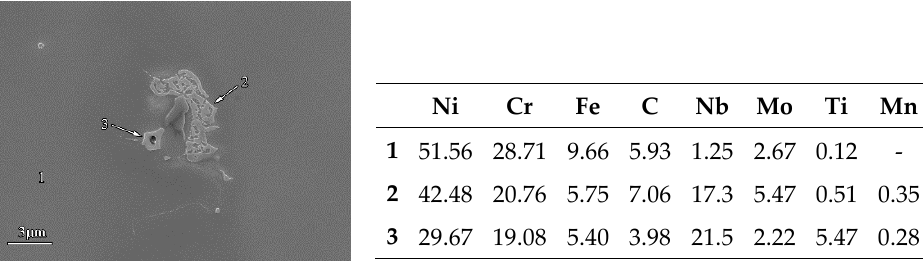
Figure 13. Compositions of precipitates in the GTAW welds of Alloy 52MSS. With an application of EMS, the dendrites of all welds became denser. The fine pre- cipitates, i.e., TiN/Cs in Alloy 52 welds, and NbCs/(Nb,Si)Cs in Alloy 52M/52MSS welds were evenly distributed in the inter-dendritic areas. The cap region was a little different in the microstructure from the middle region. There were many tiny precipitates in the middle region, but none in the cap region. This could result from welding thermal cycling that induces the fine precipitates in the middle region. In the cap region, a rapid cooling rate could inhibit the formation of tiny precipitates. Both Alloy 52 and Alloy 52M welds were characterized by a microstructure of cellu- lar dendrites (Figures 5–7). With the EMS applied, the dendrites of Alloy 52 welds grew finer, but those of Alloy 52M became coarser. A discussion on the phenomena observed with Alloy 52M welds is given below. In Alloy 52MSS welds (Figure 12), the precipitates are noted to become finer with EMS, except for the cap region. It has been indicated that EMS could refine the grains and compositional segregation of welds [18,19,23,24,26]. With grain refinement, there will be more interdendritic regions with smaller area. Therefore, this helps the large precipitates to reduce in size and distrib- ute more evenly. Besides, welding heat would prompt NbCs/(Nb,Si)Cs to precipitate in inter-dendritic regions. It is also known that Mo could induce more Nb-carbides [27,28]. With more inter-dendritic regions and Nb/Mo additions, Alloy 52MSS would have even more Nb-carbides when EMS applied. 3.2. Hardness Measurement Figure 14 shows the average micro-hardness measurements for the cap and middle regions. The hardness of Alloy 52 welds is similar to that of Alloy 52M welds. Alloy 52MSS welds have the largest hardness measurement of all the welds for their highest Nb and Mo contents. It also shows that the average hardness in the middle region is slightly higher than that for the cap of all welds. ( a ) ( b ) Figure 14. The average hardness measurements: ( a ) cap, and ( b ) middle region. The hardness measurements of all welds were improved by EMS, which could be attributed to the denser dendrites and even precipitate distribution.